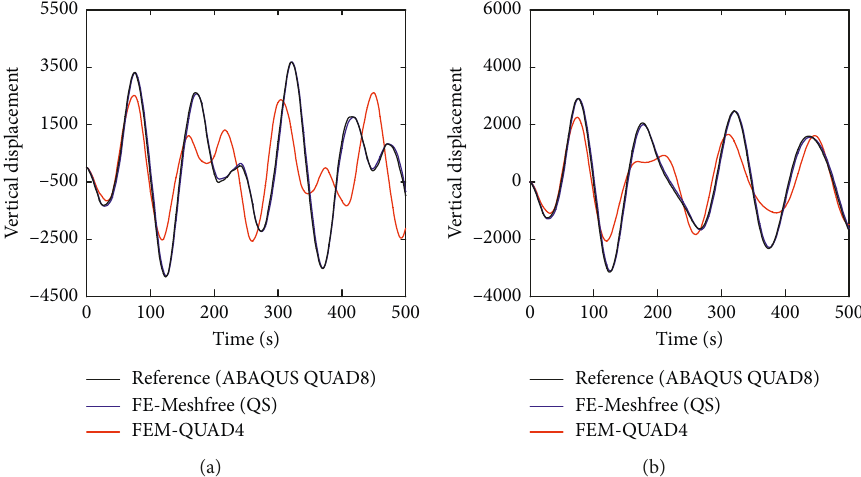
Figure 32: Transient response of spherical shell subjected to harmonic loading with ω